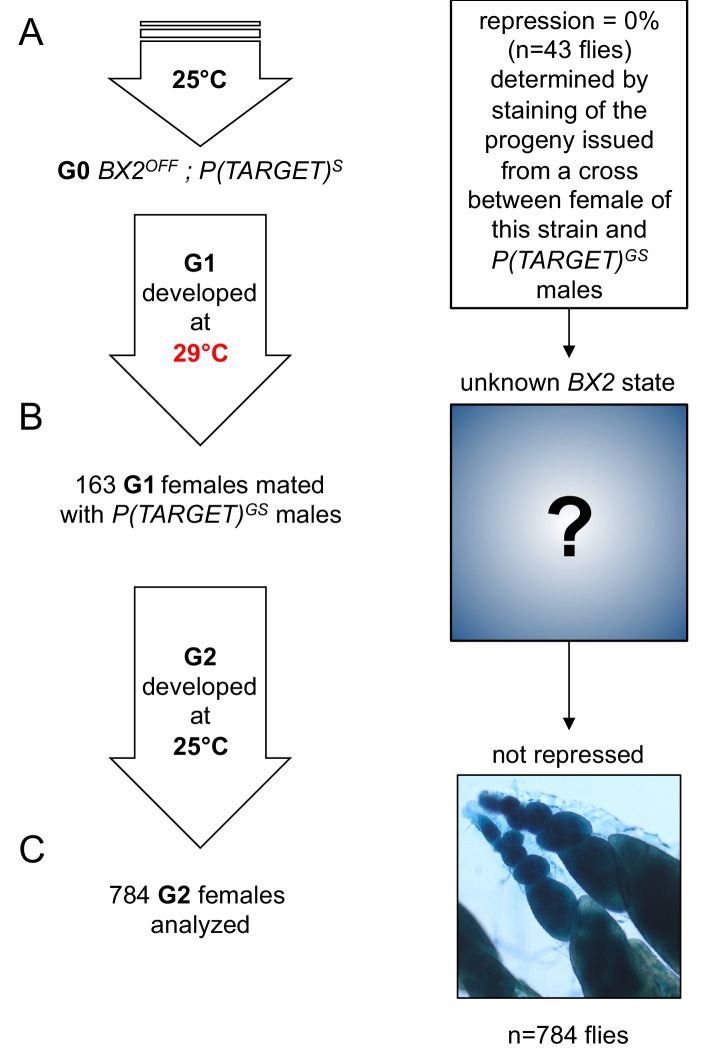
No BX2 conversion at 29°C with a transgene that is not expressed in the germline.This experiment is similar to the one in Figure 3, except that P(TARGET)GS has been replaced by P(TARGET)S expressed only in the somatic cells surrounding the germ cells. (A) The BX2OFF state of G0 females was confirmed by staining the progeny of a cross between females from this strain and P(TARGET)GS males. G0 females maintained at 25°C lay eggs at 25°C during three days. (B) Eggs were then transferred at 29°C until emergence of the next generation. 163 G1 females were mated en masse with males bearing P(TARGET)GS and left to lay for three days at 25°C. It was not possible to know the epigenetic state of BX2 in these females because of the absence of a germinally-expressed reporter transgene. (C) Analysis of the progeny of G1 females reveals that no repression was observed among 784 analyzed flies (≈94080 estimated egg chambers).